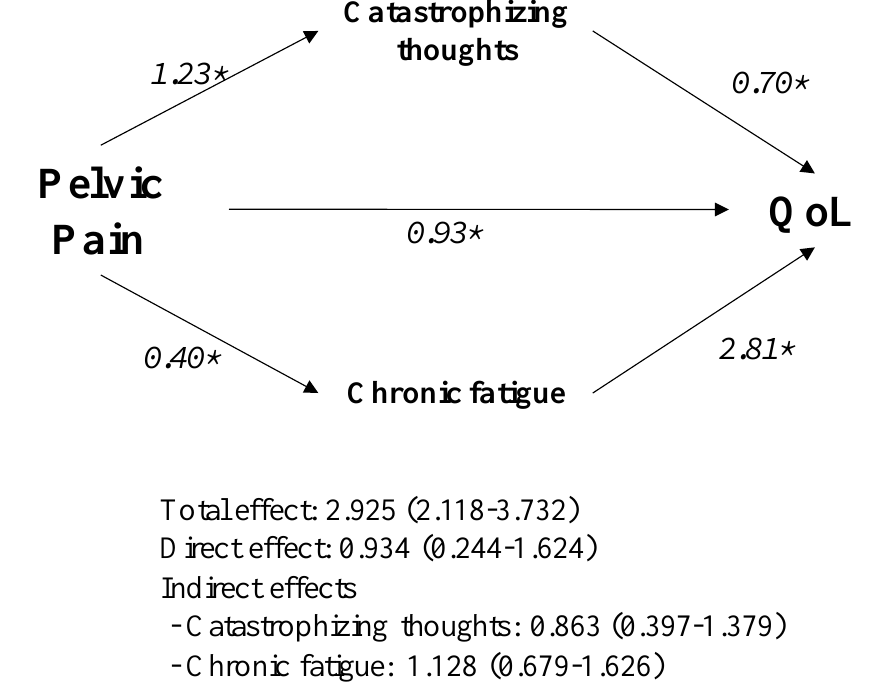
Figure 2. Mediating effect of chronic fatigue and catastrophizing thoughts on the association between pelvic pain and quality of life (QoL) in Spanish women with endometriosis. * Mediating effects were considered significant when zero was not located within the confidence intervals. Analyses were conducted with the macro PROCESS for SPSS.